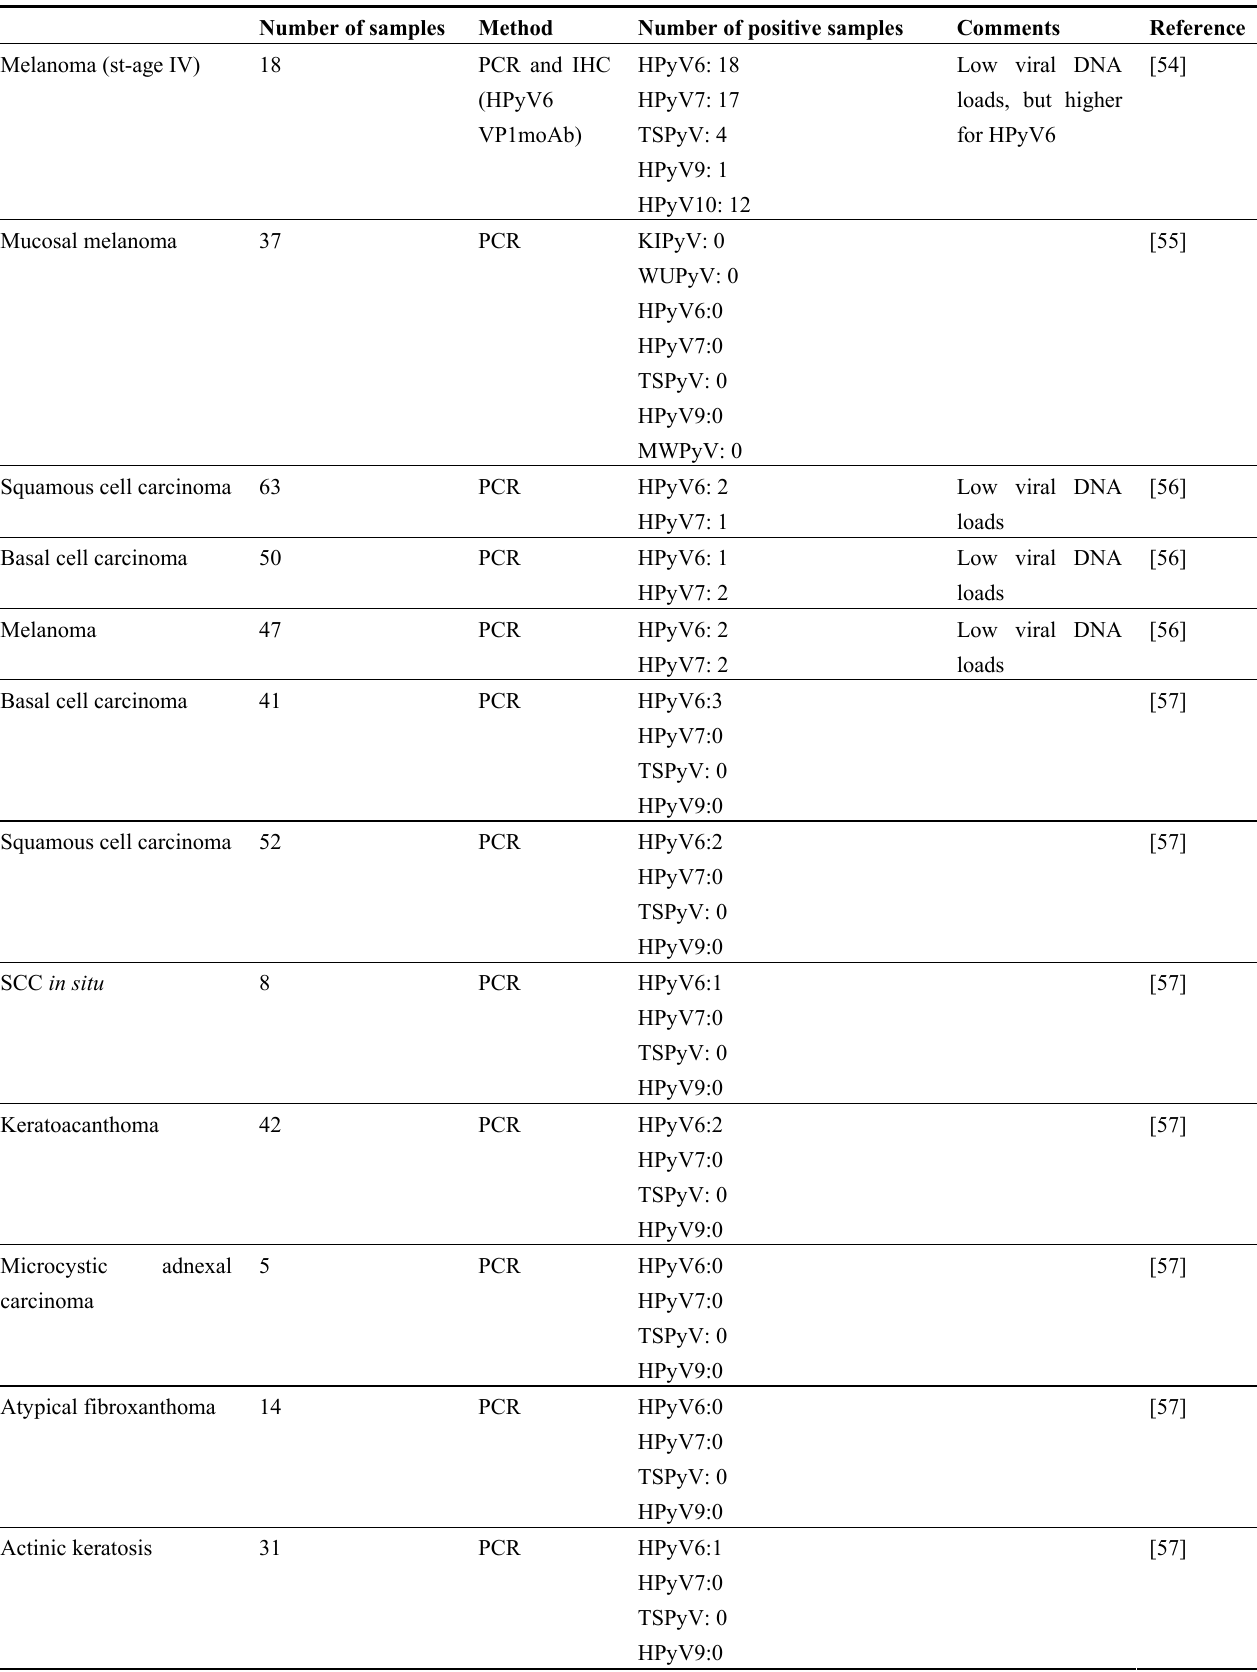
Table 1. Prevalence of the novel human polyomaviruses in human cancers. BK